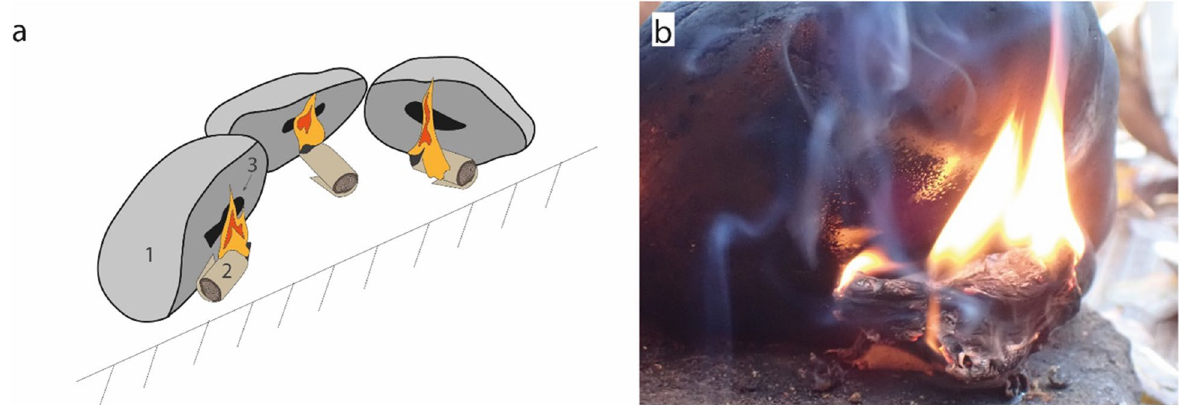
Figure 1. Experimental birch tar production with the condensation method. ( a ) Experimental set up of three large cobbles (1) with their flat surface slightly tilted to create an overhang. The bark fragments or rolls (2) were lighted and placed beneath the cobbles on which the condensed birch tar (3) is deposited. ( b ) Close up image of one cobble with a partially burnt bark roll and a shiny dark layer of tar accumulating on the cobble